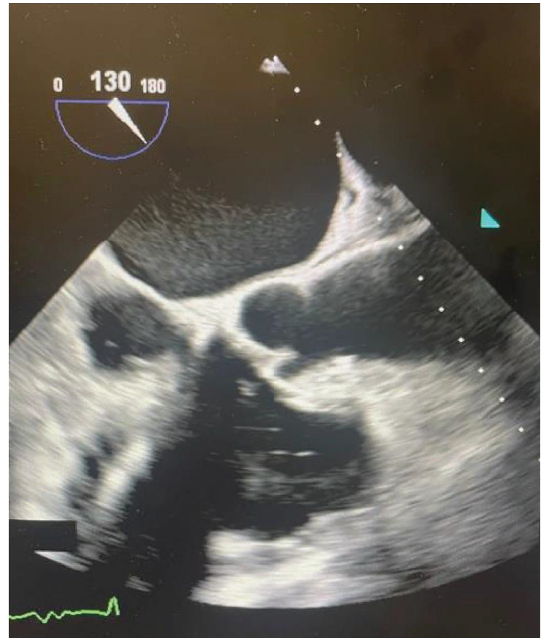
Figure 7: TEE of aortic valve vegetation 1.